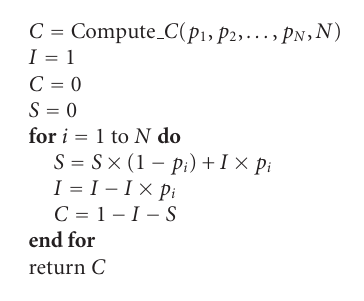
Algorithm 1: Computing C , given the transmission probabilities p i